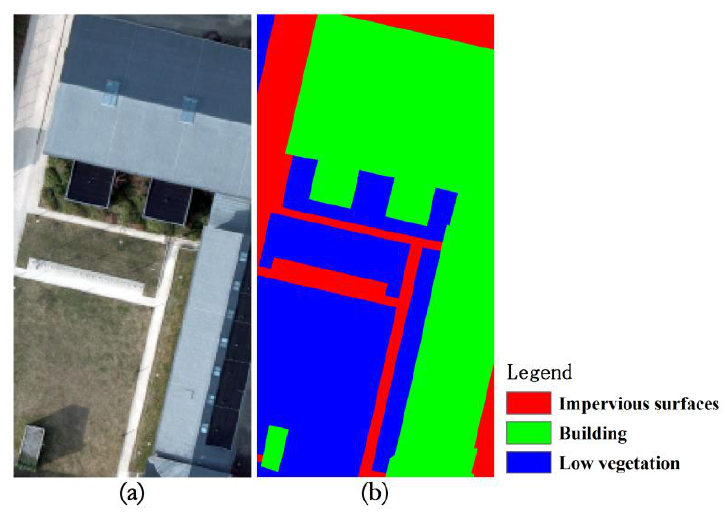
Figure 7. Potsdam image: ( a ) true color original Potsdam image and ( b ) ground truth reference image.